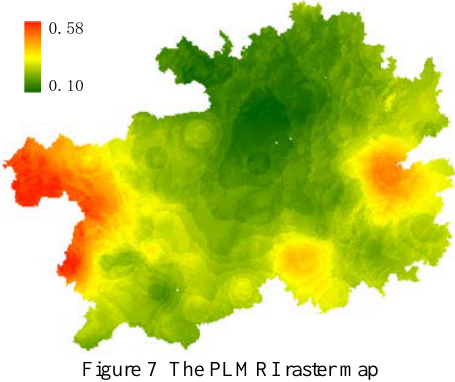
Figure 7 The PLMRI raster map